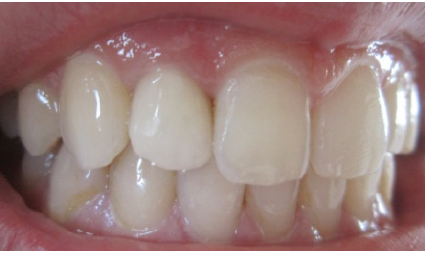
Figure 7. Final result showing an improvement of aesthetic